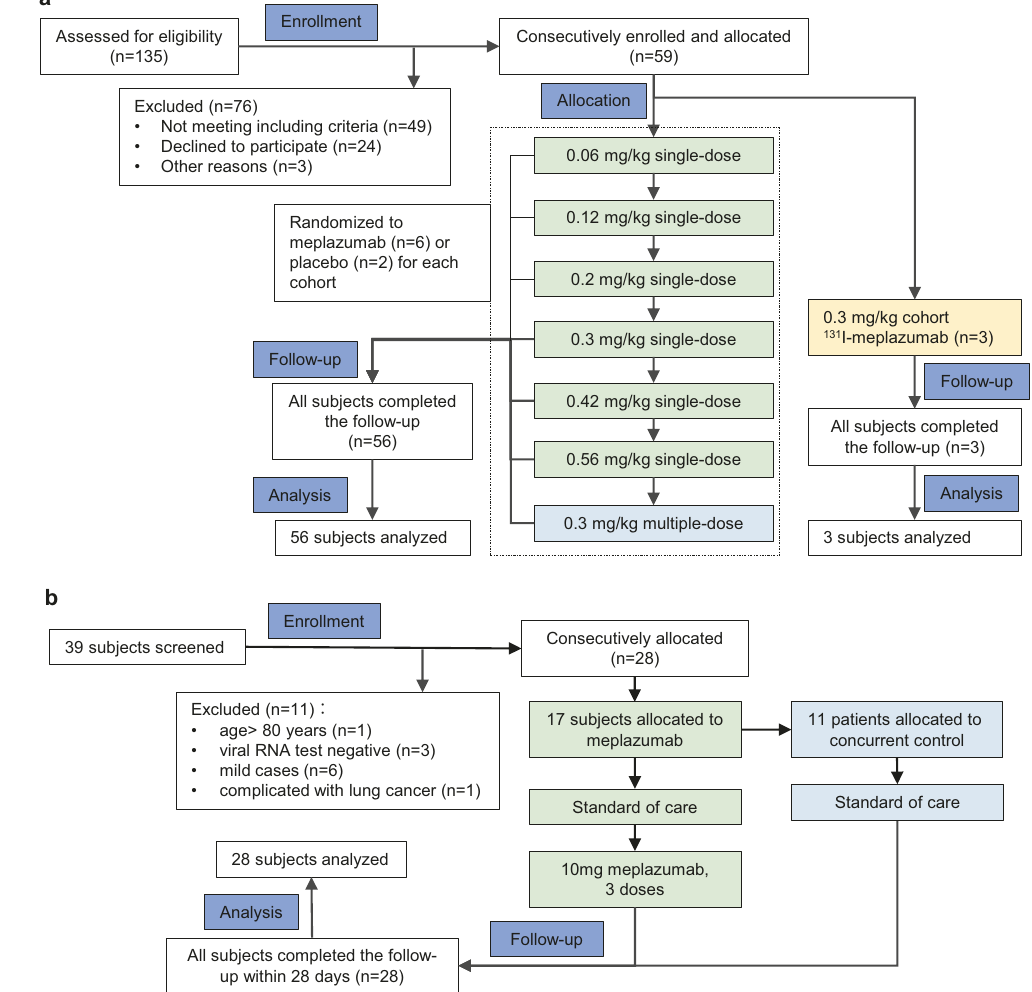
Fig. 1 Flow chart of the phase 1 trial ( a ) and exploratory phase 2 trial ( b